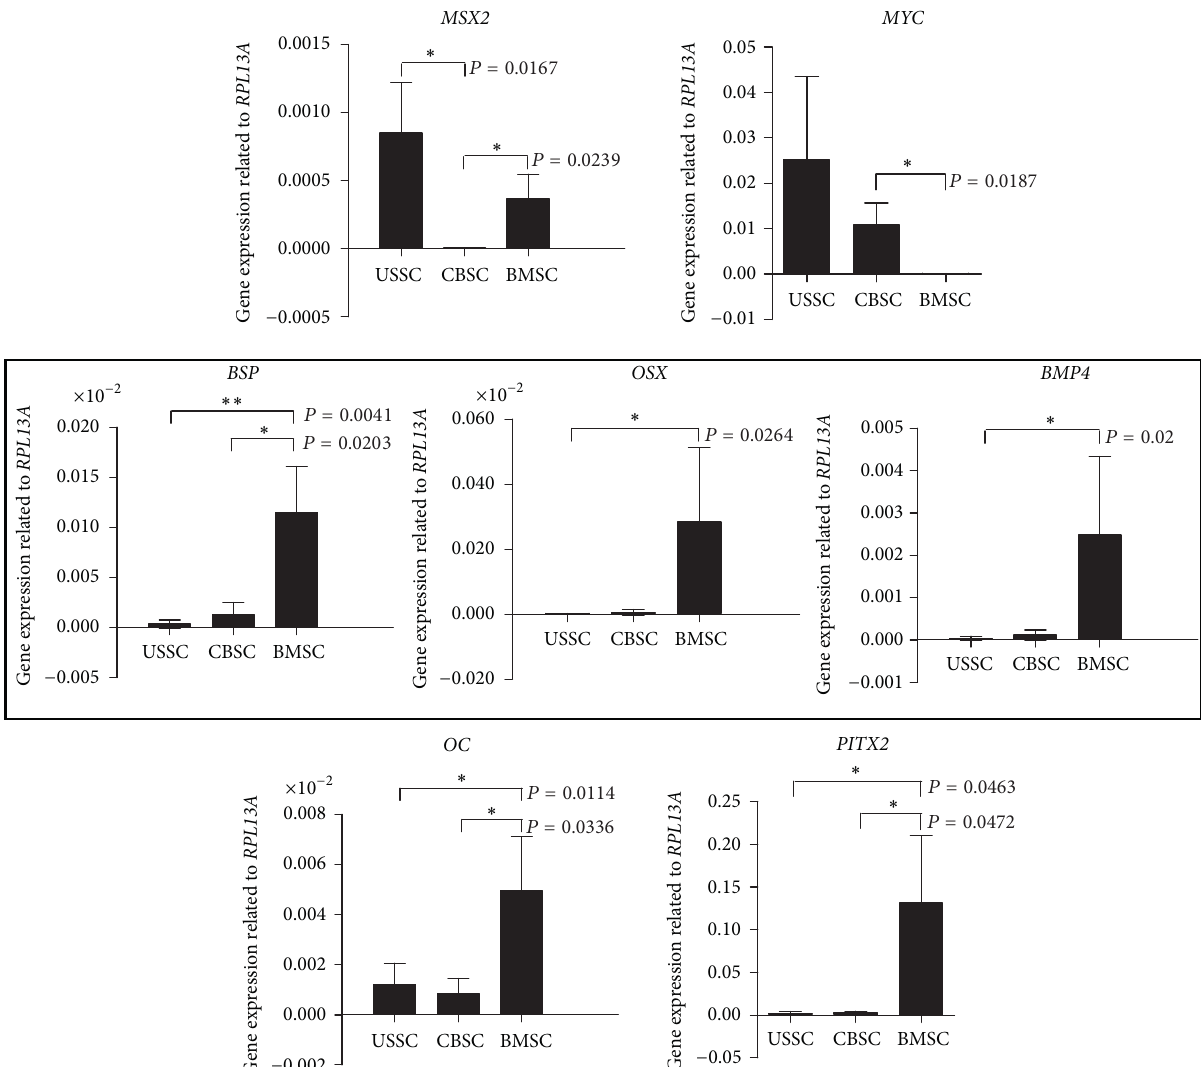
Figure 2: Quantitative RT-PCR analyses of genes expressed differentially in USSC, CBSC, and BMSC. Illustrated are the arithmetic means and standard deviations of at least 3 different cell lines per cell type. ∗ 𝑃 = 0.01 to 0.05, significant; ∗∗ 𝑃 = 0.001 to 0.01, very significant (unpaired 𝑡 -test). RPL13A was used as housekeeping gene. Genes selected for overexpression experiments are highlighted. MSX2: homolog of muscle segment homeobox Drosophila 2, MYC: V-Myc avian myelocytomatosis viral oncogene homolog, BSP: integrin-binding sialoprotein, OSX (SP7): osterix, BMP4: bone morphogenetic protein 4, OC (BGLAP): osteocalcin, PITX2: paired-like homeodomain transcription factor 2, and RPL13A: ribosomal protein